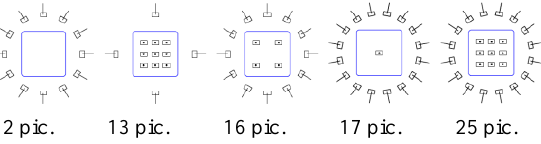
Figure 7: Top view of the investigated image (black rectangles) configuration with the inclination of the camera, indicated by the vertical axis, relative to the location of the bin (blue square) Independently of the number of images, it is possible to compute a valid filling volume with the photogrammetric method. However, the calculated filling volumes differ, with the median values ranging between 172 litres and 186 litres. Figure 8 shows the results for the different number of the camera positions of the three-quarter filled yellow bin.